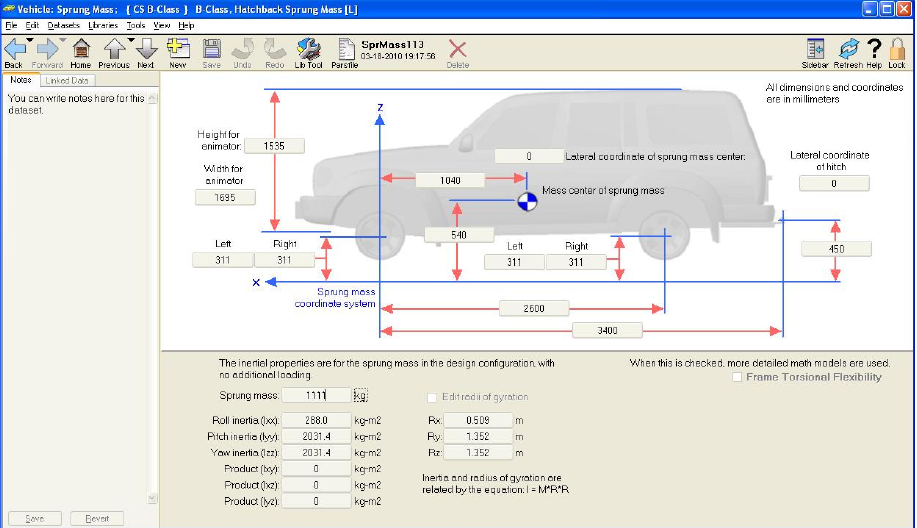
Figure 12. Carsim 8: vehicle parameter